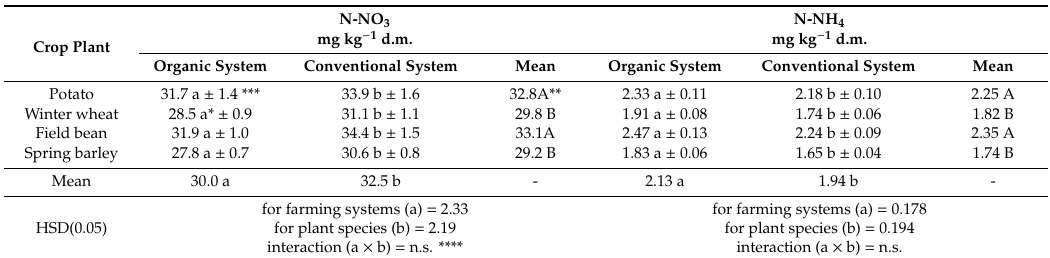
Table 14. Nitrogen forms in soil in the 0–25 cm soil layer. Crop